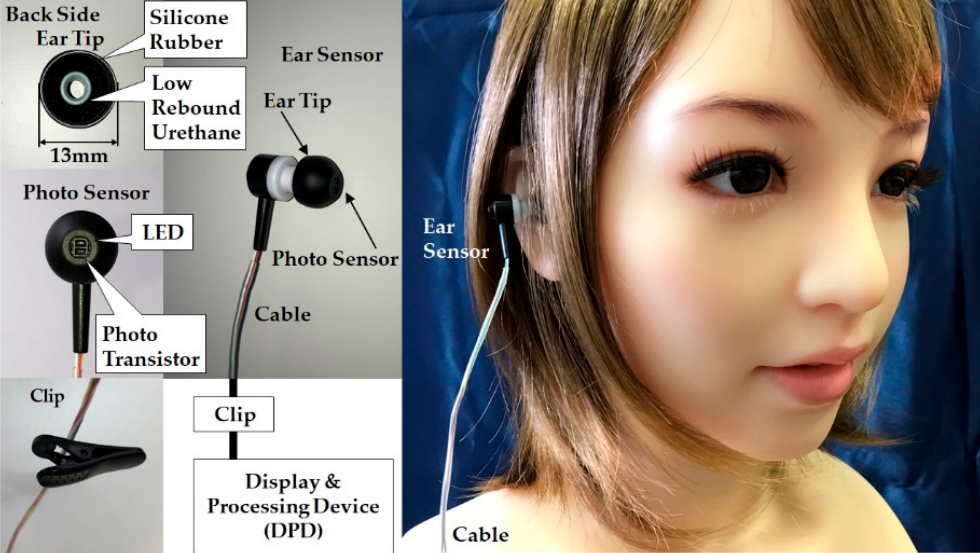
Figure 1. External diagram of the earable point-of-care ear sensor for respiratory rate measurement (POCER). The earable POCER uses an ear sensor attached to one ear. The earable POCER is comprised of one ear sensor for measuring the respiratory rate of the measured subject, a display and processing device (DPD) that calculates and displays the respiratory frequency from the values measured by the ear sensor, and one clip for fixing the cable stretching from the ear sensor to the DPD on the subject’s clothes. A photo sensor is attached to the ear sensor. The surface of the ear tip on the ear sensor is covered with silicone rubber, and the inside is made of low-rebound urethane. Using this silicone rubber and low rebound urethane, the ear sensor fits snugly in the ear hole.